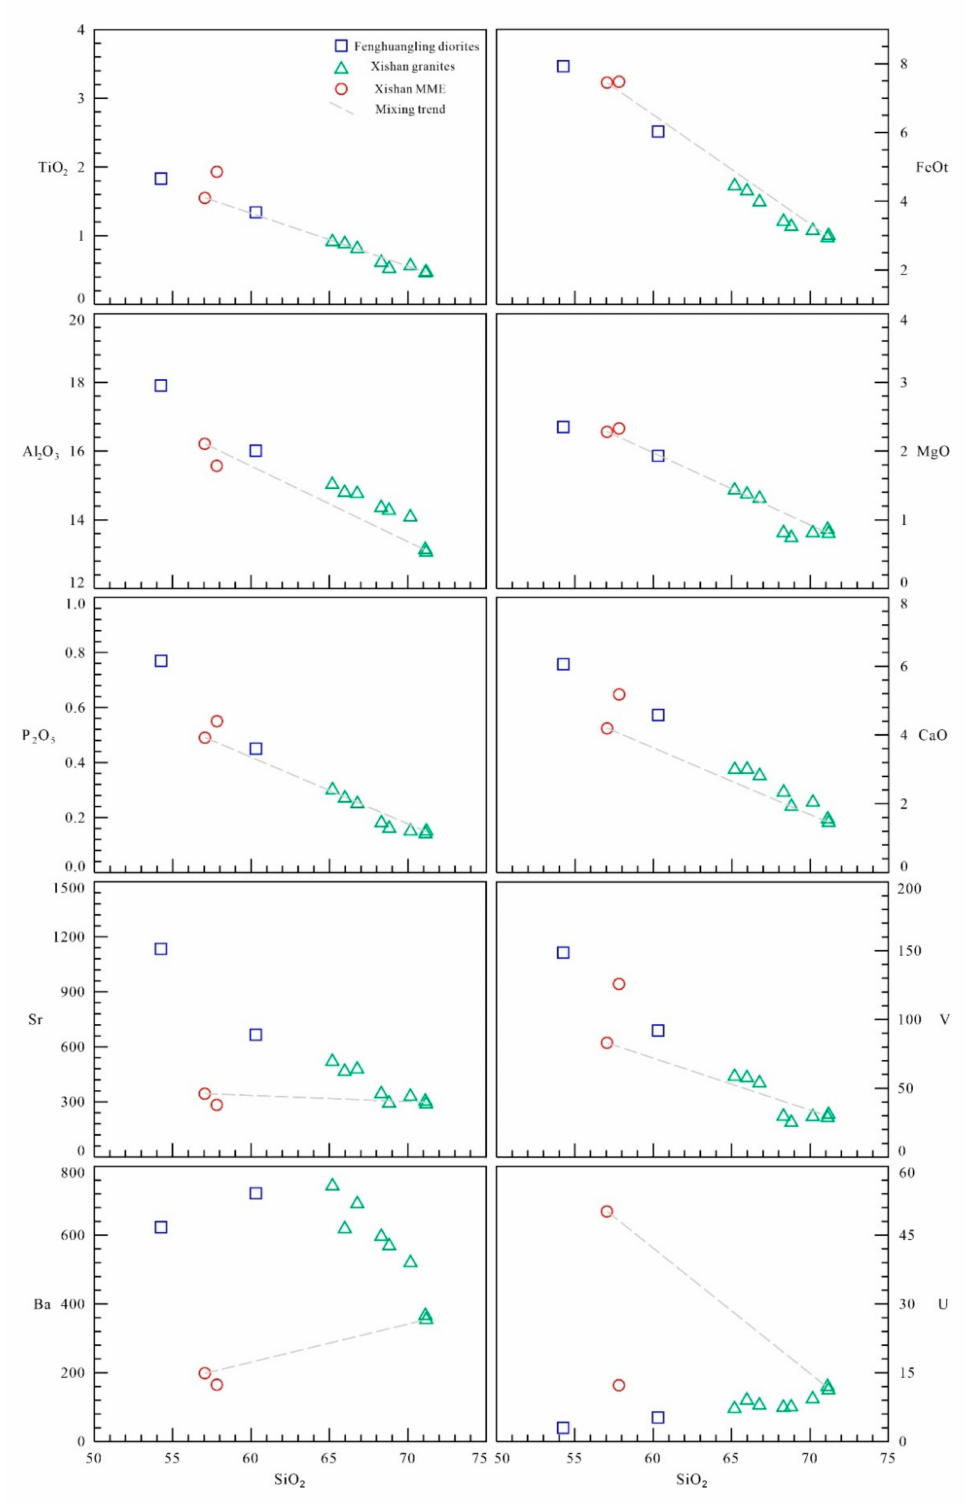
Figure 9. Harker diagrams for the Guiping